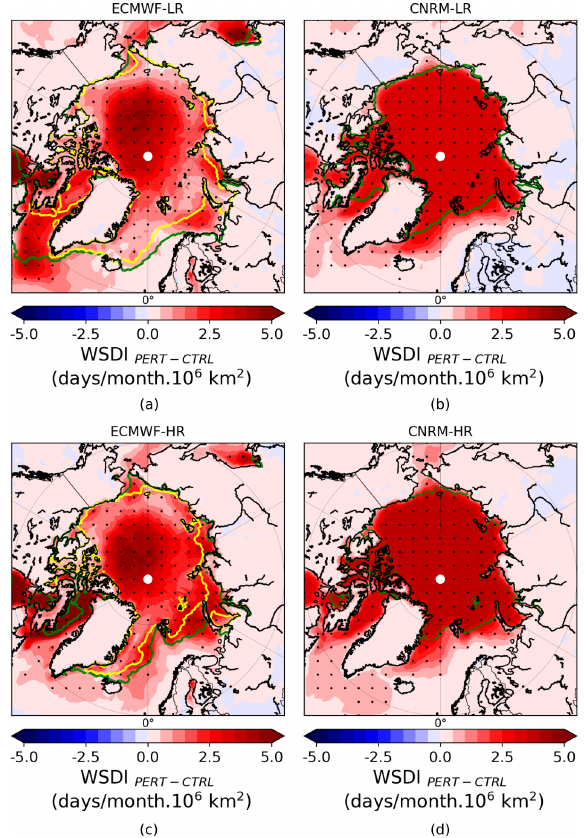
Figure A4. Ensemble mean changes (PERT − CTRL) in summer (JAS) warm spell duration index scaled by the amount of sea ice extent loss in ECMWF-LR (a) , CNRM-LR (b) , ECMWF-HR (c) and CNRM-HR (d) . The dots show where the response is statisti- cally significant according to a 10% level FDR test associated with a Kolmogorov–Smirnov test. The green and yellow lines represent the sea ice edge (15% ice concentration) from CTRL and PERT,